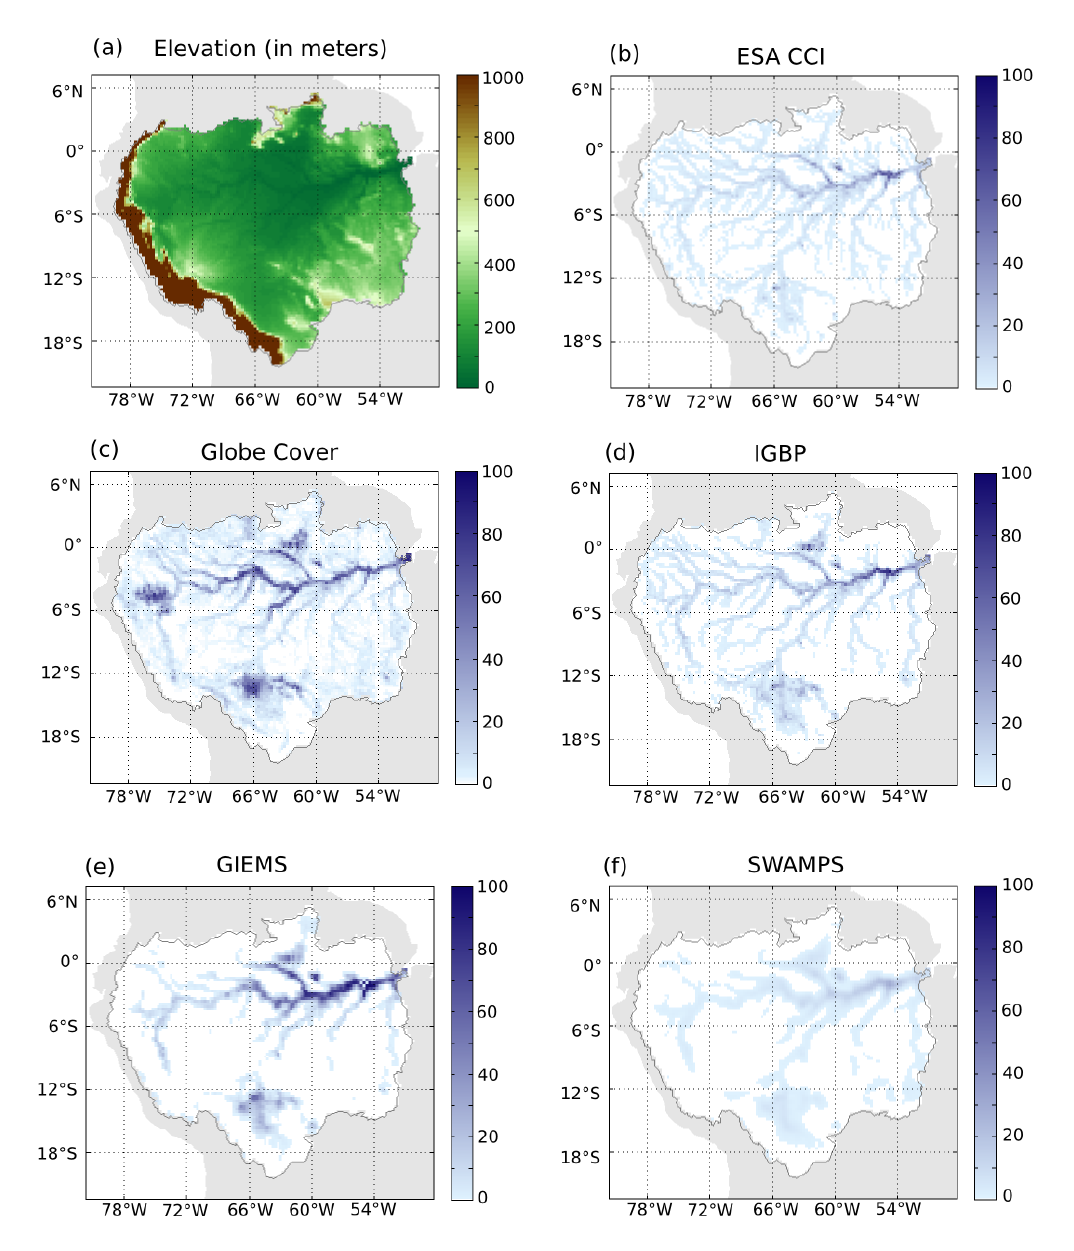
Figure 2. ( a ) Elevation (in meters) of the Amazon Basin from the SRTM data rescaled in the EASE v2.0 grid; spatial distribution of the water surface from: ( b ) ESA CCI; ( c ) IGBP; ( d ) Globe Cover; ( e ) average inundation extent from GIEMS from 1993–2007 over the Amazon Basin; and ( f ) average inundation extent from Surface Water Microwave Product Series (SWAMPS) from 2010–20over the Amazon